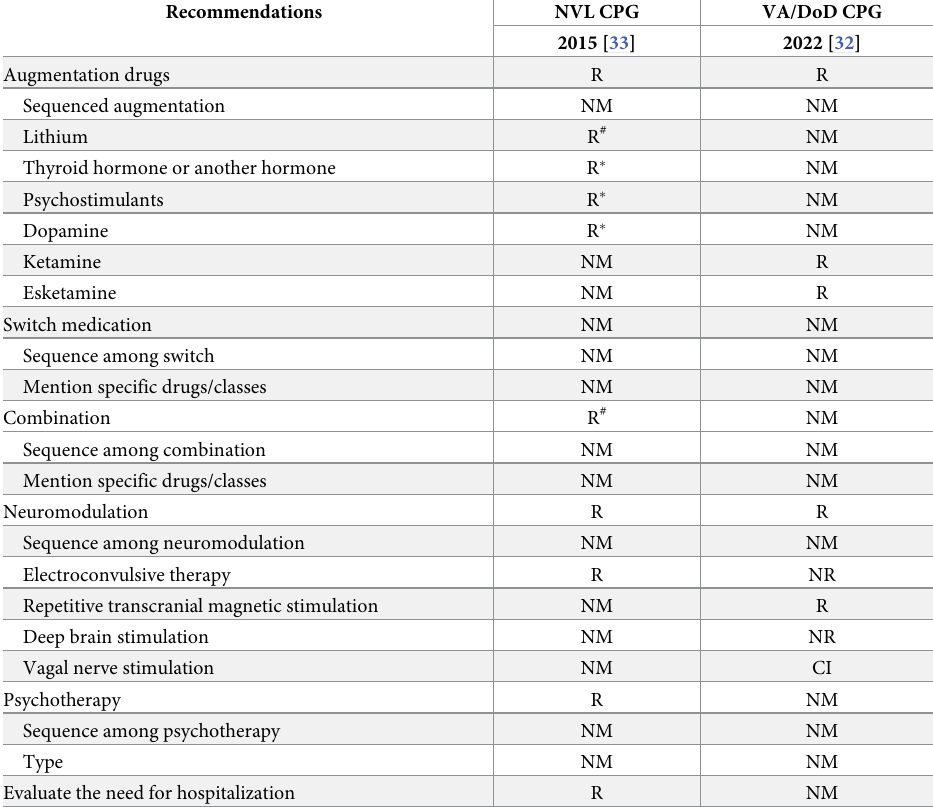
Table 1. Recommendations for the management of TRD obtained from the selected